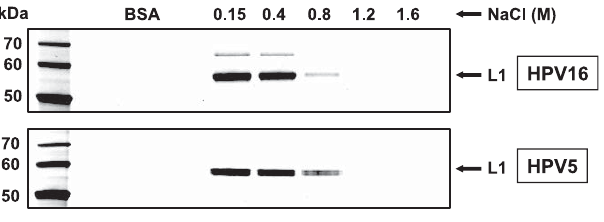
Figure 3. Capsids Bind Carrageenan